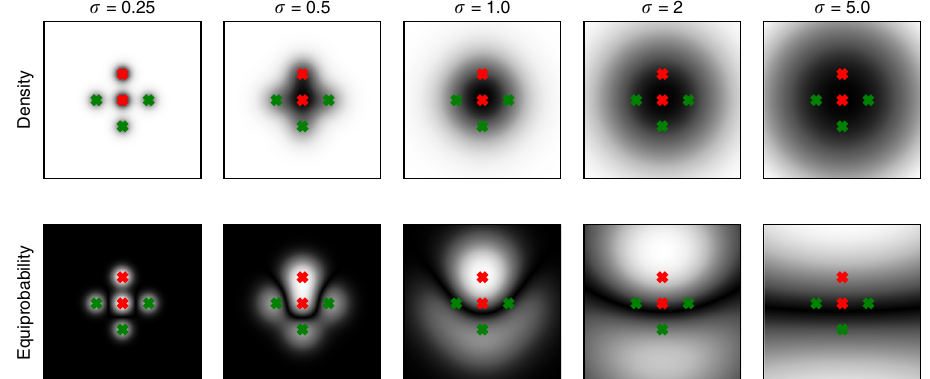
Fig. 7 Gaussian noise can lead to linearization of decision boundaries. Shows a simple nonlinear binary classi fi cation problem consisting of two mixtures of Gaussians in 2D space with identical isotropic covariance ( σ ). Samples of the fi rst class are generated by the two Gaussians marked with red crosses; samples of the second class are generated by the three Gaussians marked with green crosses. The fi rst row indicates the overall probability density for the generating mixtures. The second row indicates equiprobability — i.e., f ( x, y ) = | P red ( x, y ) − P green ( x, y )| — areas in which both red and green classes are equally likely (black). The resulting black margin separating the red and green mixtures represents the ideal decision boundary. Adding Gaussian noise — i.e., increasing σ — gradually turns the decision boundary from a highly nonlinear U-shape ( σ < 2) to a linear decision boundary ( σ > 2). Hence, in certain data scenarios, high levels of Gaussian noise can linearize an irregular decision